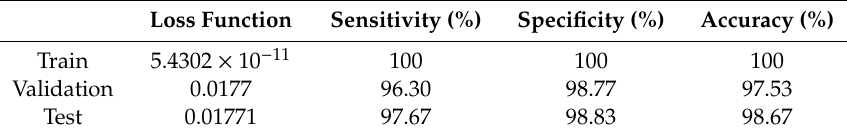
Figure 4. Simulation results using cross-validation. Table 4. Simulation results using 10-fold cross-validation.